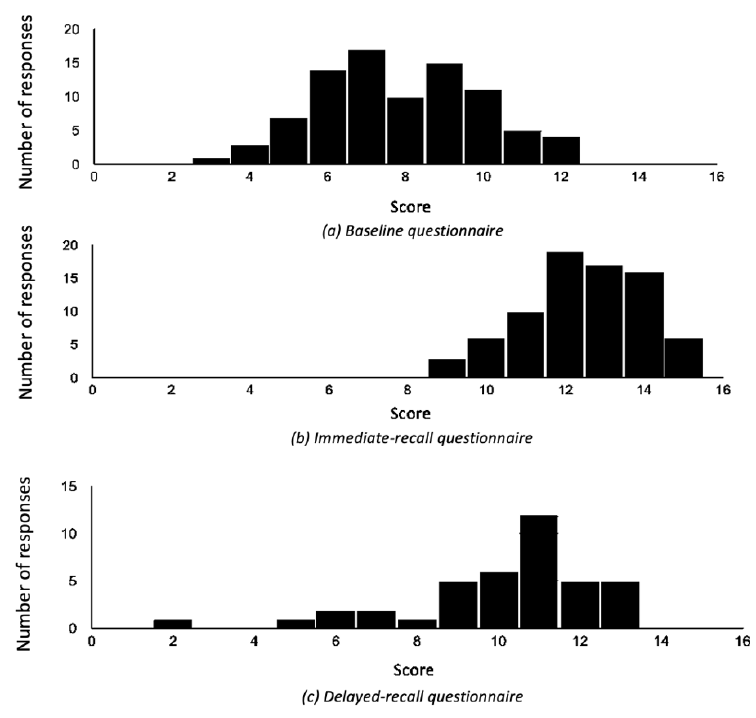
Figure 3. Medical student scores on ( a ) baseline, ( b ) immediate- and ( c ) delayed-recall question-